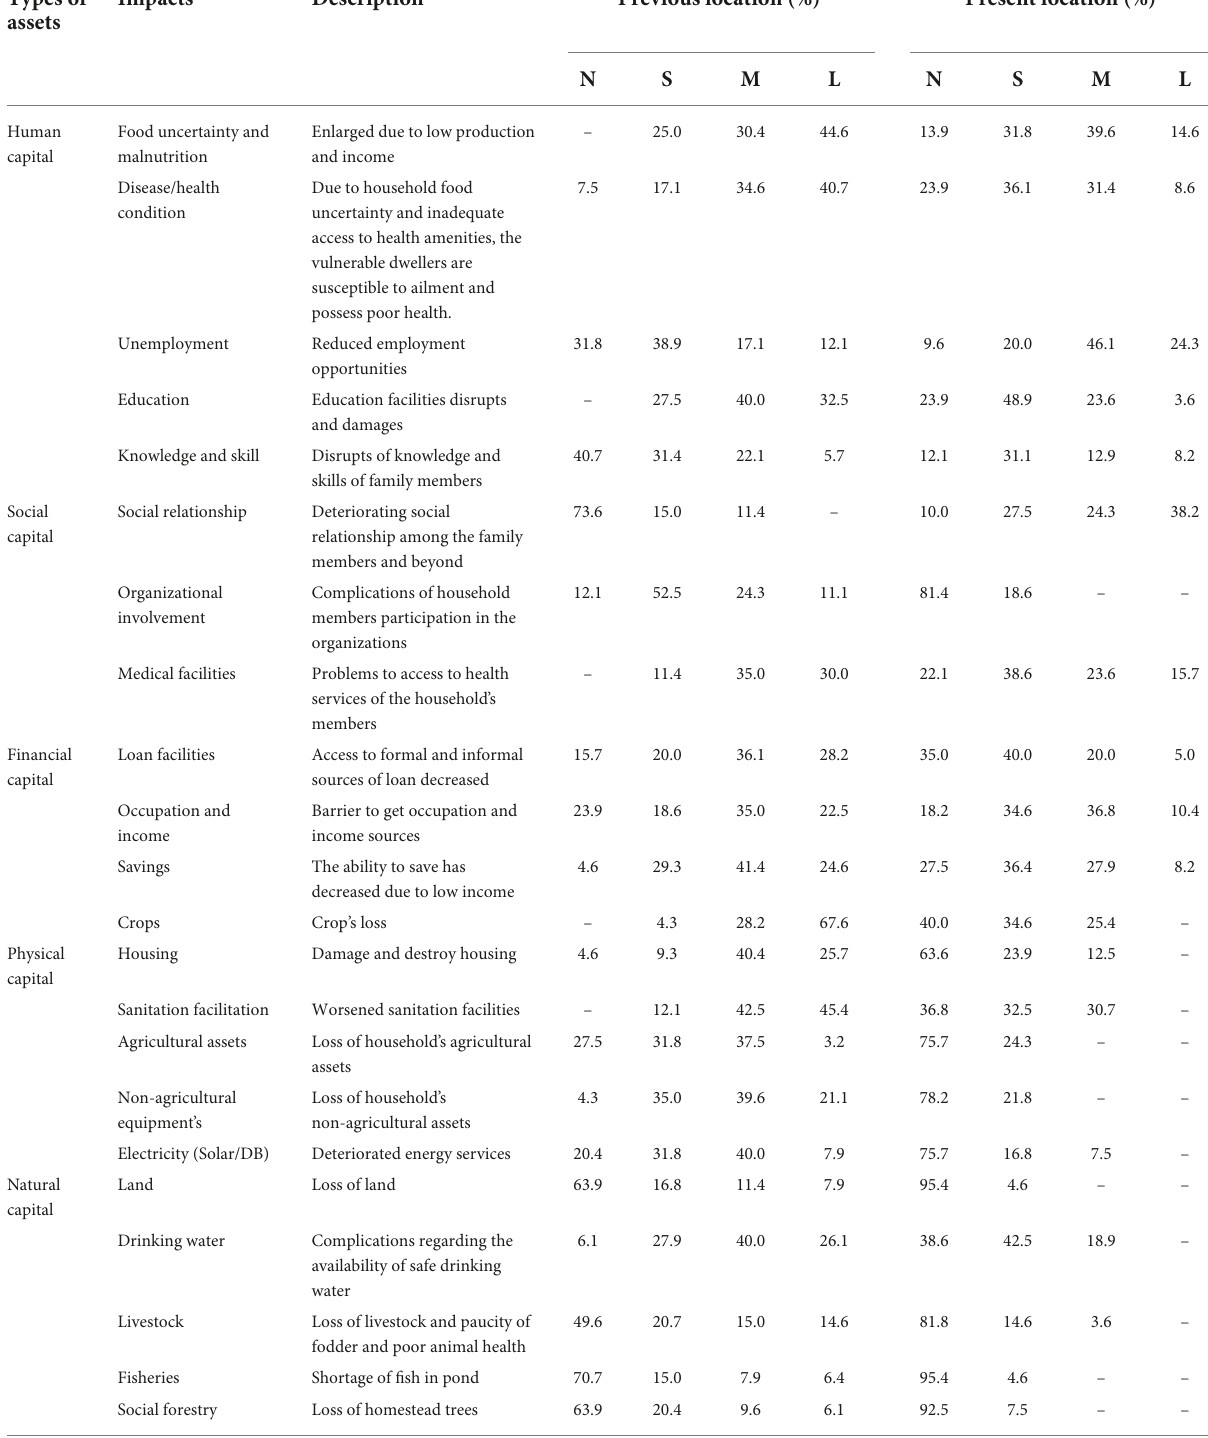
TABLE 4 Perception of displaced people on the climate change impact on livelihood in the prior and present